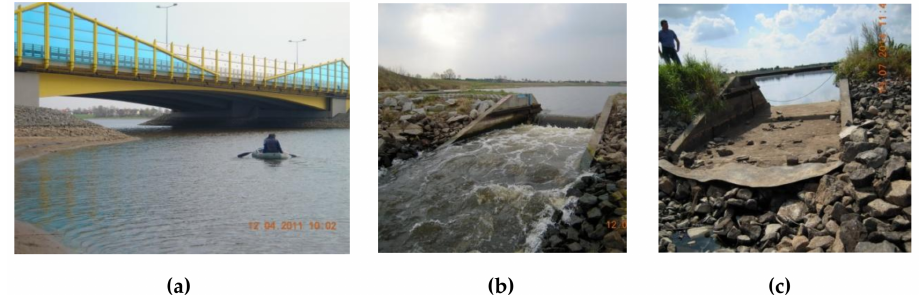
Figure 4. Stare Miasto in the Powa river: ( a ) The bridge with highway A2; ( b ) the sluice in the internal dam in 2011; ( c ) the sluice in the internal dam in 2014 (author J.